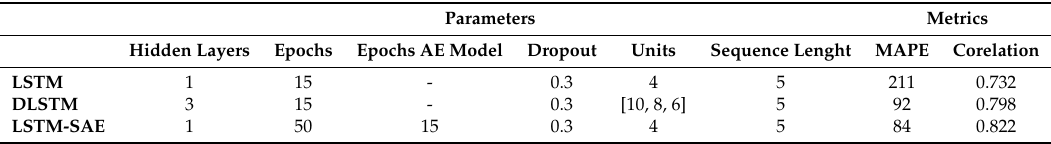
Table 1. Training parameters and Metrics.